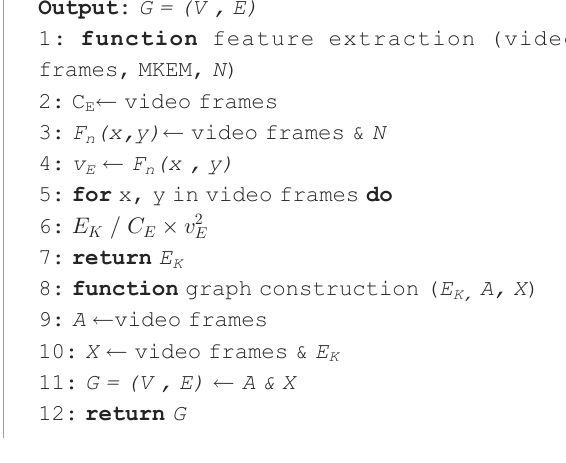
ALGORITHM 1 Feature extraction and graph construction.